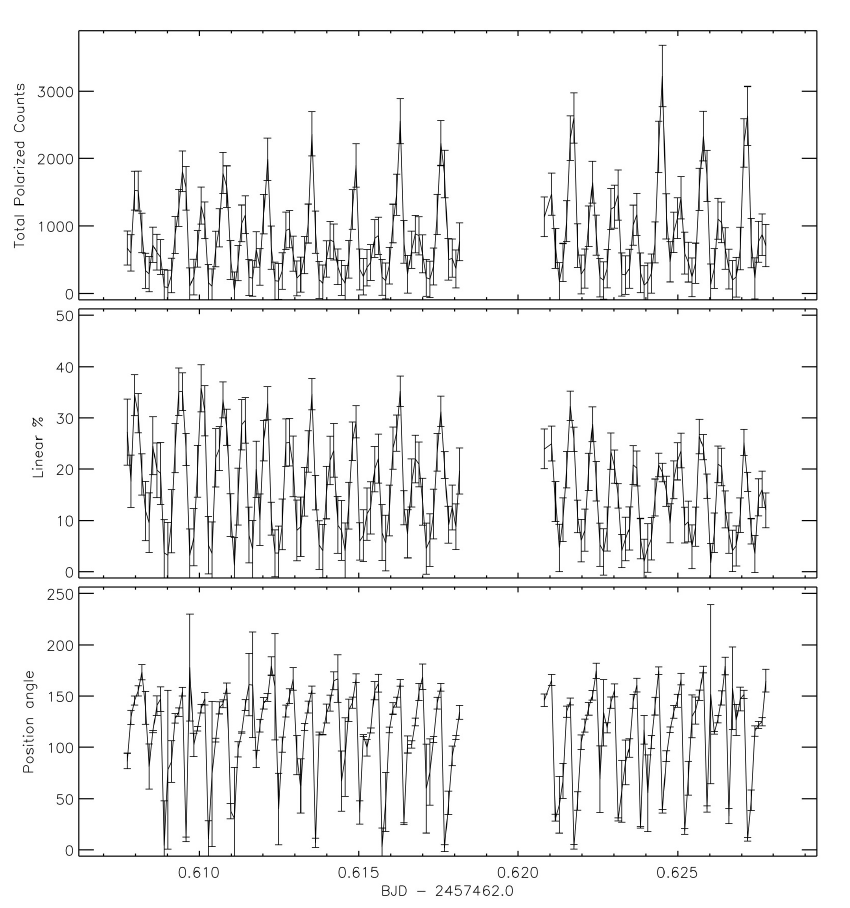
Figure 1. Photopolarimetry of AR Sco covering the band ∼ 570–900 nm, taken on 14 March 2016, in 10 s bins. The panels show, from the top, the total polarized flux ( s ), degree of linear polarization ( p ) and position angle of linear polarization ( θ